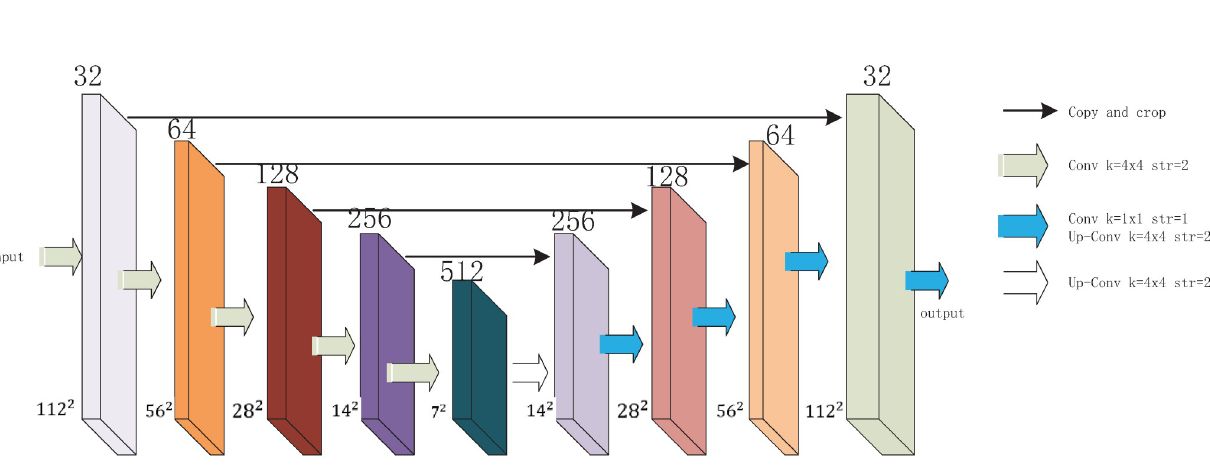
Fig 5. Detailed structure of autoencoder